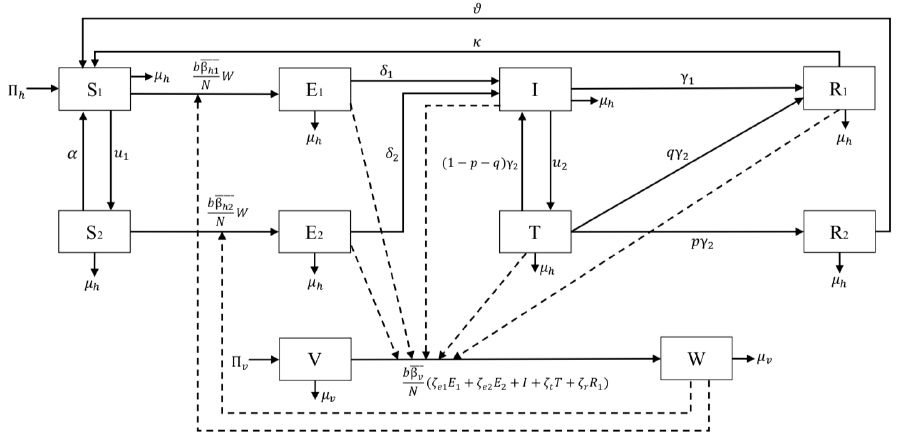
Figure 1. Transmission diagram of model